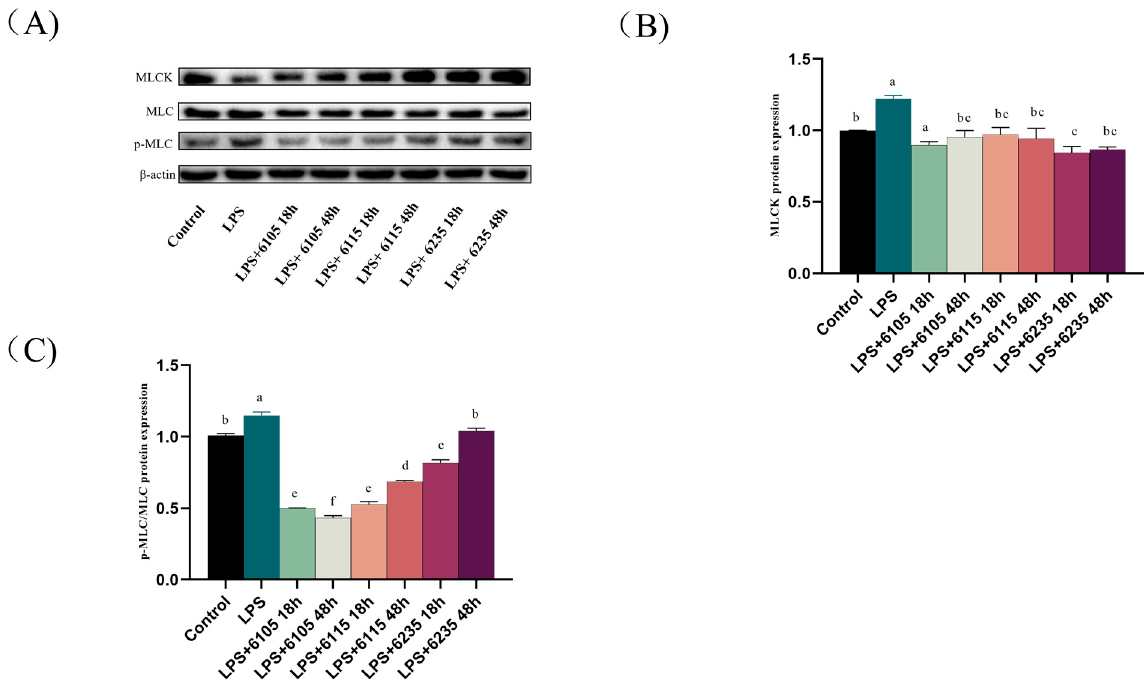
Figure 7 . Effects of heat ‐ killed L. paracasei (HK ‐ LP) 6105, 6115, and 6235 (1 μ g/mL) at different cultivation times (18 h or 48 h) on the expression of the myosin light-chain kinase (MLCK), p-myosin light-chain (MLC), and MLC ratios in lipopolysaccharide (LPS) (100 µ g/mL)-treated Caco-2 cell monolayers. Western blot images of MLCK, p ‐ MLC, and MLC ratios ( A ). Relative protein expression of MLCK ( B ), p ‐ MLC, and MLCK ratios ( C ). HK ‐ LP 6105, 6115, and 6235 were incubated for 18 h and 48 h, respectively; after that, they were heat ‐ killed for 30 min at 100 °C. Control: untreated control cell; LPS: LPS ‐ treated cells. Each result is represented as the mean ± standard error of the mean (SEM) from three independent experiments. Different lowercase letters (a, b, c, d, e, f) indicate different levels of significance ( p < 0.05) and the same letters represent no significant difference ( p > 0.05).